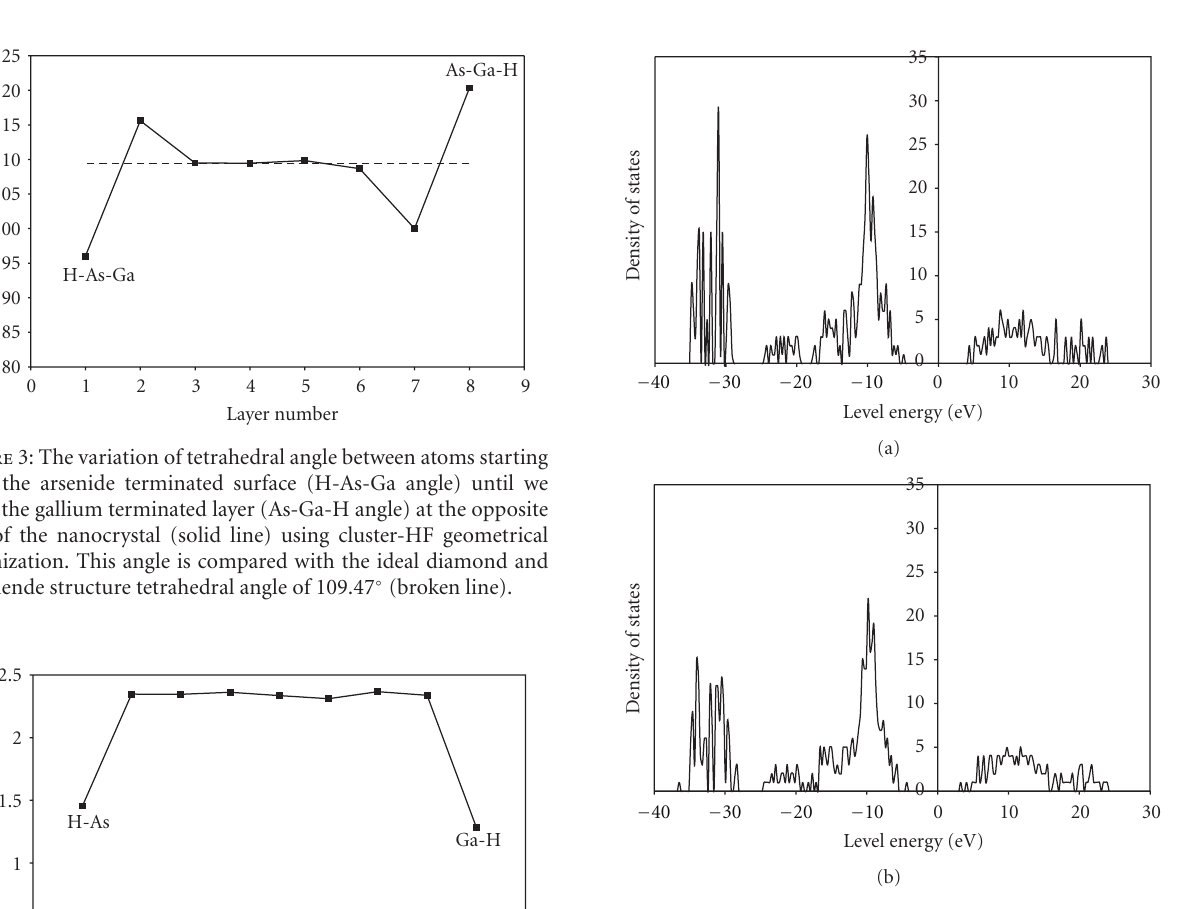
Figure 5: Density of states of hydrogenated GaAs nanocrystal cluster (a), and hydrogenated GaAs nanocrystal cluster with an oxygen atom replacing two hydrogen surface atoms (b). Hartree- Fock theory is used in the calculations. Density of states is collected in intervals of 0.01 Hartree (0.27211